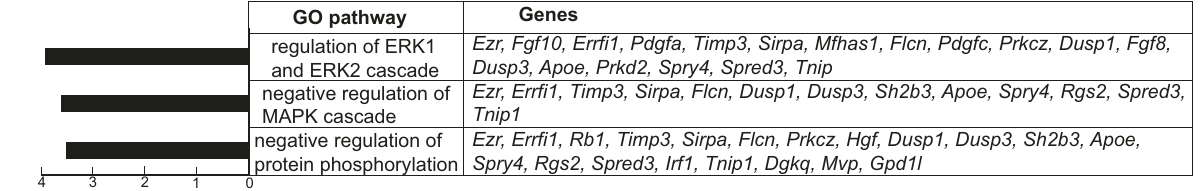
Fig. 7 Tbx1 affects gene expression and chromatin accessibility of MLPs. a Scheme of ATAC-seq data analysis. b Pie chart of ATAC-seq peaks of GFP + cells from Tbx1 Cre/ + ; ROSA26-GFP f/ + (Ctrl) and Tbx1 Cre/f ; ROSA26-GFP f/ + (cKO) embryos at E9.5 ( n = 3). A total of 13,546 peaks, de fi ned as CARs, commonly accessible regions, were found in both Tbx1 Cre Ctrl and cKO datasets. A total of 5872 peaks, de fi ned as DARs, differentially accessible regions, in which peak intensity was changed (FDR ≤ 0.05) between Tbx1 Cre Ctrl and cKO datasets. c Pie chart showing the intersection of CARs with ATAC-seq peaks of GFP + cells from Mesp1 Cre/ + ; ROSA26-GFP f/ + embryos at E9.5 ( n = 3). Among 13,546 CARs, a total of 12,392 peaks were also found to open in Mesp1 Cre lineages and thus referred to as CARs-Mesp1. d Pie chart showing the intersection of DARs with ATAC-seq peaks of GFP + cells from Mesp1 Cre/ + ;ROSA26-GFP f/ + embryos at E9.5 ( n = 3). Among 5872 DARs, 2185 were also found to open in Mesp1 Cre lineages and thus referred as DARs-Mesp1. Of the DARs-Mesp1 regions, 638 had a T-box motif. e The motifs found in DARs-Mesp1 regions by Homer (hypergeometric optimization of motif enrichment) with default settings. f Venn diagram of genes with ATAC-seq DARs-Mesp1 regions and DEGs in MLPs from scRNA-seq. Of the 770 DEGs in the MLPs, 160 genes showed decreased ( P value < 2.2e-16) and 46 genes showed increased were found as DARs-Mesp1 ( P value < 2.2e-16). g Enriched biological processes for the 160 genes with both DARs-Mesp1 and reduced expressed in Tbx1 cKO MLPs. X axis indicates adjusted P values. h Enriched biological processes for the 308 genes with reduced expression in Tbx1 cKO but without DARs-Mesp1. X axis indicates adjusted P